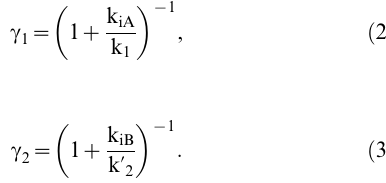
Table 1. Estimated ranges for parameter values based on previous experimental and computational studies.